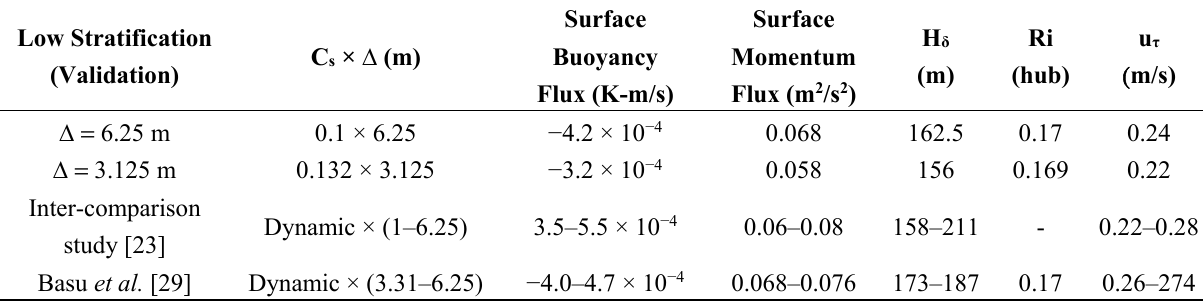
Table 1. Grid convergence of surface buoyancy flux, surface momentum flux, ABL height ( H ), Richardson’s number at hub-height (Ri (hub)) and friction velocity (u τ ) conducted δ with grid spacing of 3.125 m and 6.25